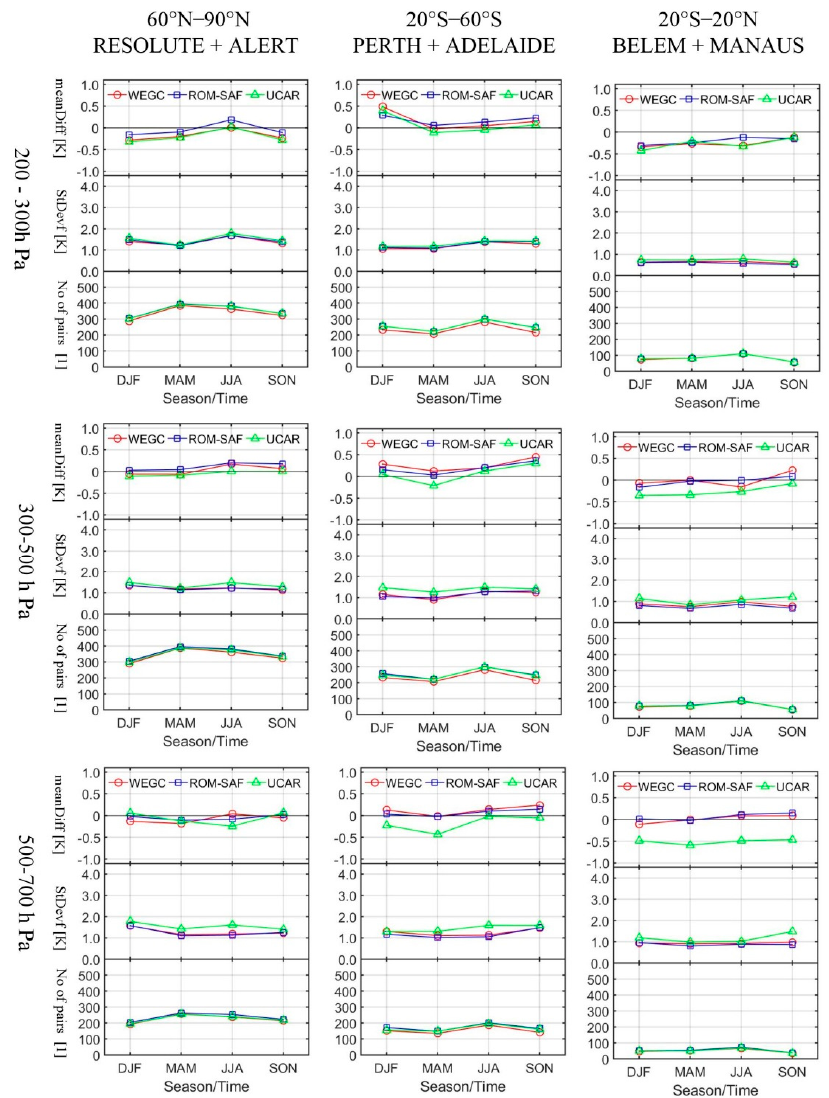
Figure 8. Mean temperature differences (meanDiff, top row of each sub-panel) with standard deviations (StDev, middle row) between RO and RS and number of paired samples (bottom row) over selected stratospheric layers for the four temporal phases of DJF, MAM, JJA, and SON; from top to bottom, selected stratospheric layers are 200–300 hPa, 300–500 hPa, and 500–700 hPa, respectively; from left to right, results for latitudinal bands of 60°–90°N, 20°–60°S and 20°S–20°N are shown respectively.